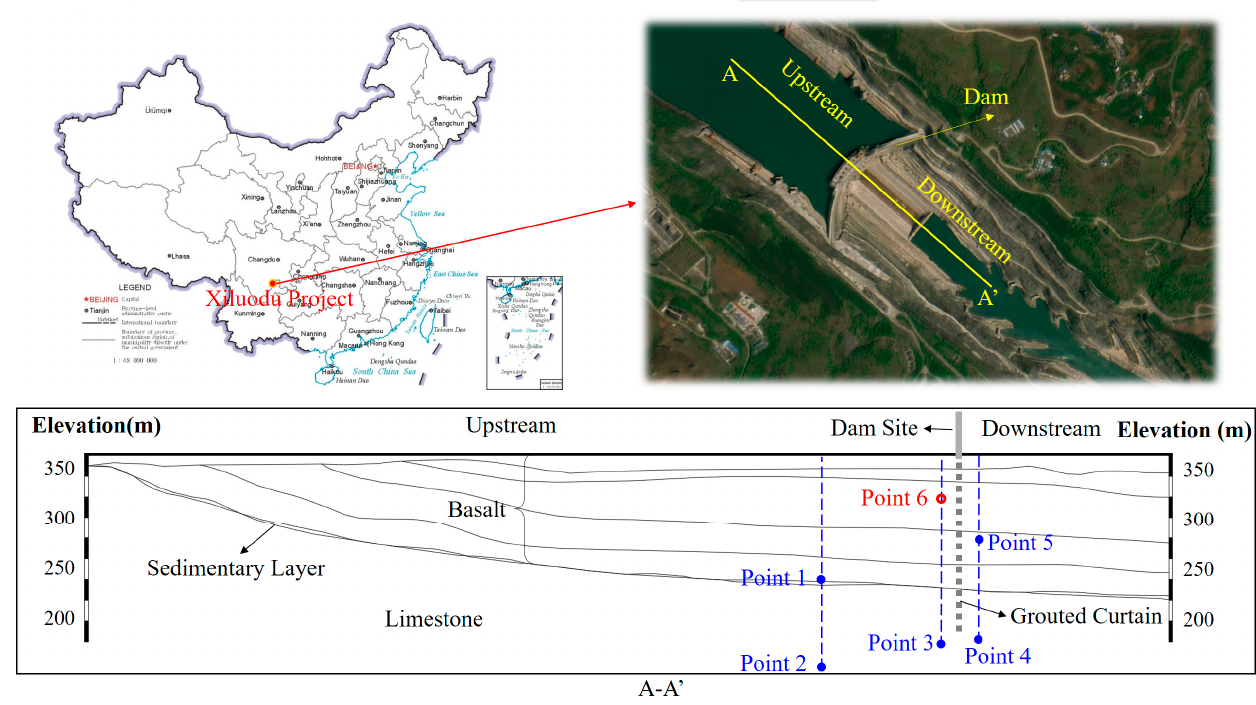
Figure 5. Geological conditions along the river section at the Xiluodu dam site.